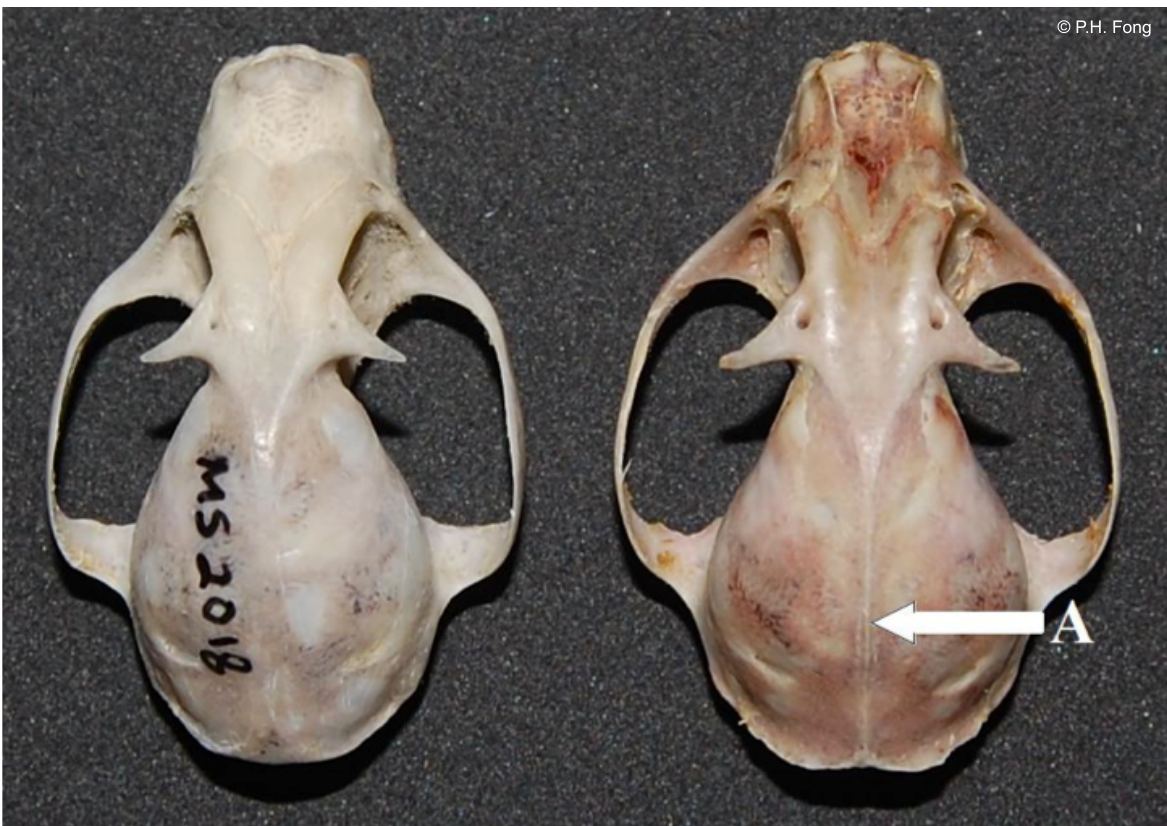
Image 2. Female C. horsfieldii (left) with less prominent sagittal crest versus male C. horsfieldii with prominent sagittal crest